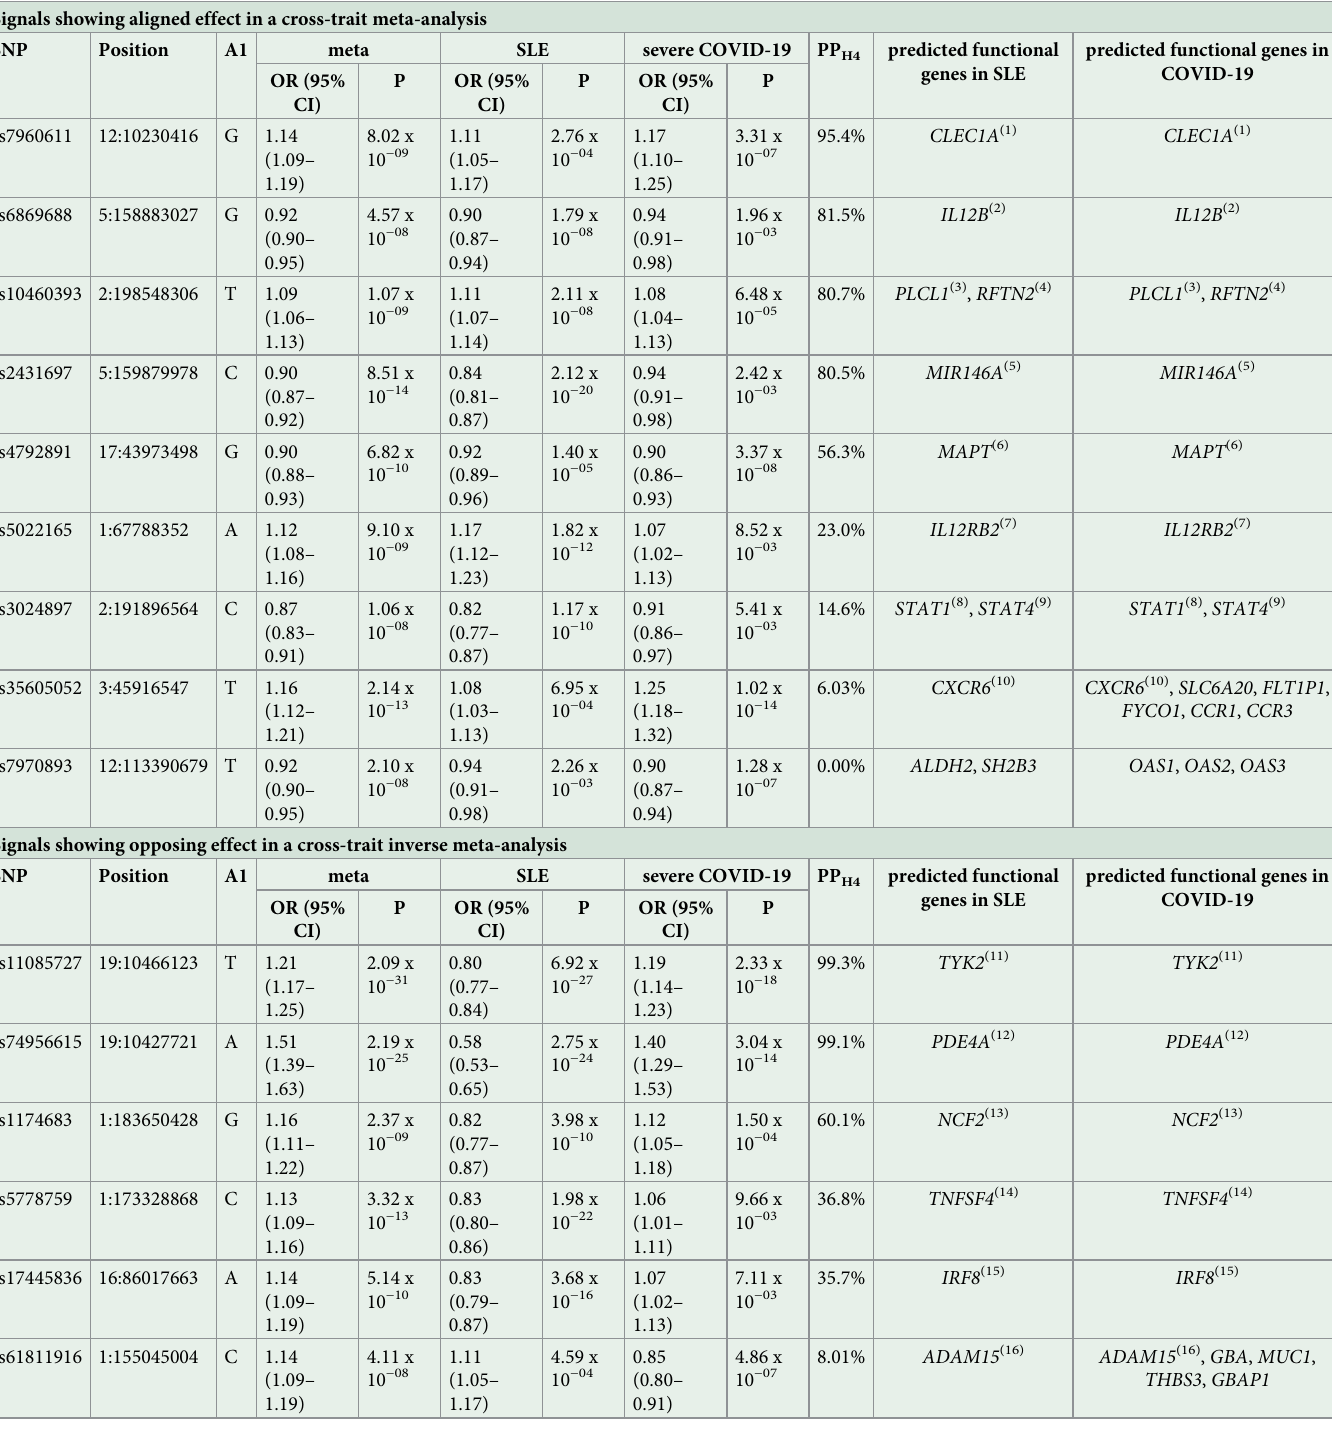
Table 1. Association results for lead SNPs in the cross-trait meta-analysis/inverse meta-analysis of severe COVID-19 and SLE data. Posterior possibilities (PP H4 ) of colocalisation between signals were estimated with region ± 1 Mb of lead SNPs, if there are multiple independent signals the highest PP H4 of colocalisation was shown. Pre- dicted functional genes were inferred by lead SNP in the region and its LD with coding variants, eQTL data (GTEx v8 and eQTLGen), ENCODE ChIP-seq marker data, GeneHancer interactions data, and published functional studies. Signals showing aligned effect in a cross-trait meta-analysis